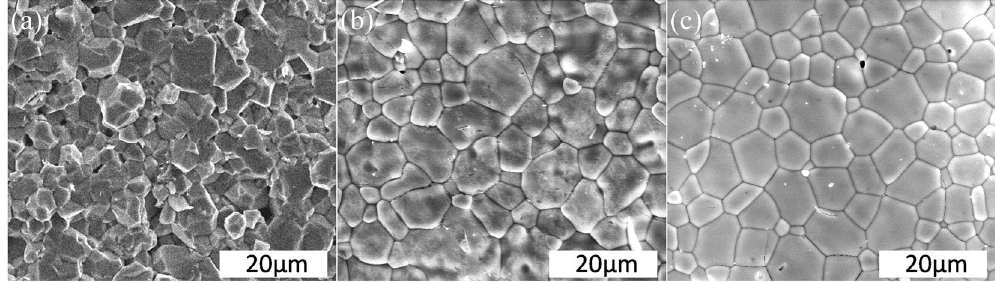
Figure 2. SEM images of the (Na 0.5 Bi 0.5 )(Mo 1 − x W x )O 4 ( a ) x = 0.0 (fractured surface), ( b ) x = 0.5 and ( c ) x = 1.0 ceramics sintered at 720 °C for 2 hr.